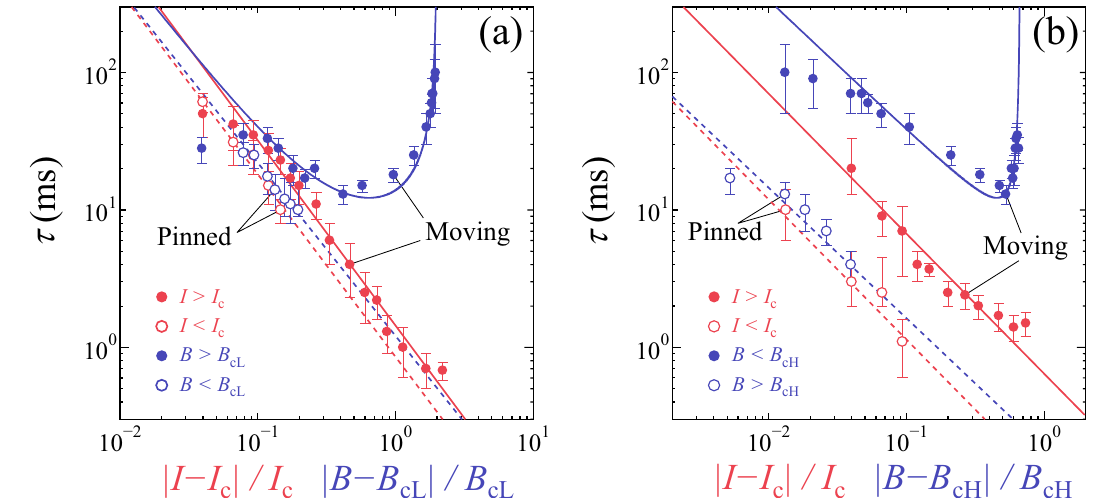
Figure 5. The relative width of the critical region. The quantities for the abscissa indicate the normalized / I c (red circles) and I I c distance from the critical point. ( a ) log τ measured in B 1.27 T plotted against = | − | / B cL (blue circles), which are collected from the data in Figs 1b and 2c, B B cL that at I 0.375 mA against = | − | respectively. All the symbols and lines correspond to those in Figs. 1b and 2c. ( b ) log τ measured in 3.8 T plotted / I c (red circles) and that at 0.375 mA against / B cH (blue circles), which are collected I I c B B cH against | − | | − | from the data in Figs. 1d and 2d, respectively. All the symbols and lines are the same as those in Figs. 1d and 2d. The open and solid circles in ( a , b ) correspond to the data in the pinned and moving phases, respectively. The error bars in τ mainly correspond to the fitting errors resulting from the uncertainty in determining a